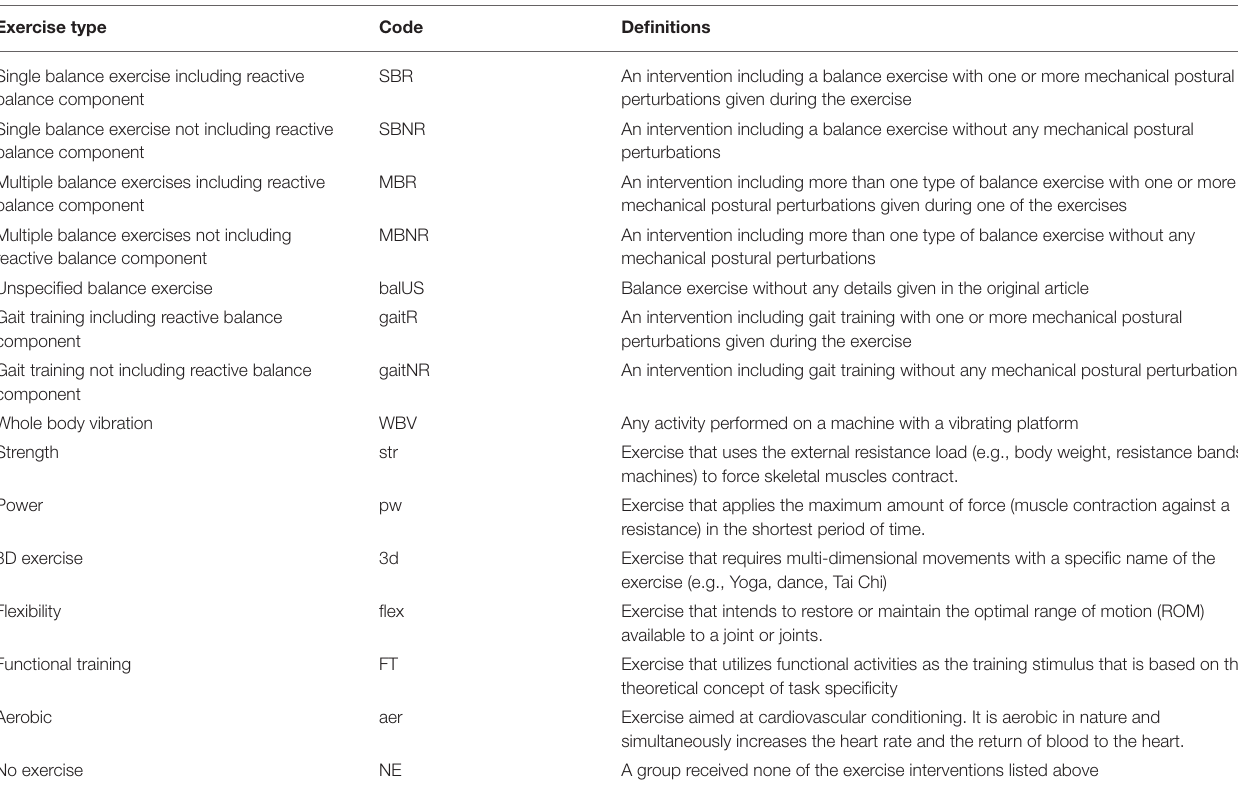
TABLE 1 | Definitions of exercise